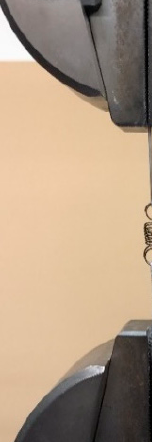
Figure 4. Experimental setup for tensile tests of the NiTi SMA spring.